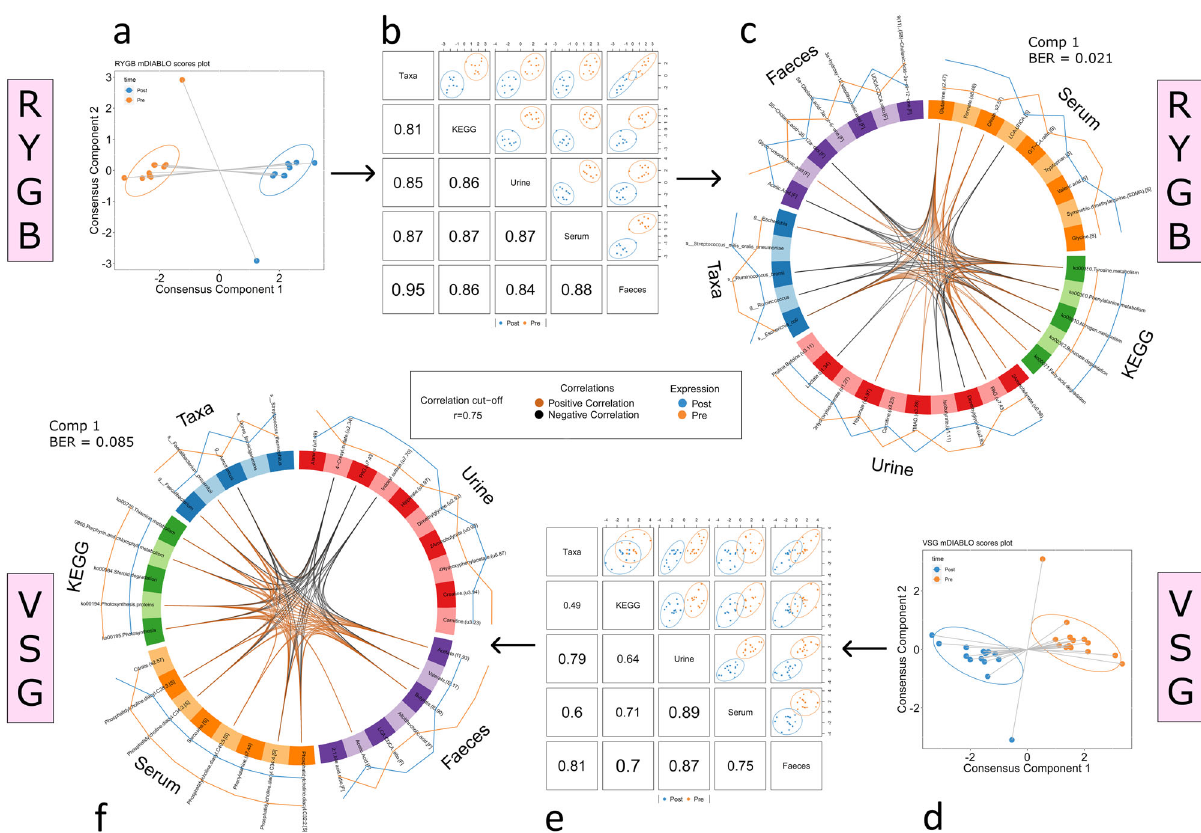
Fig. 6 Integration of metabolite and gut microbiota datasets. Multi-omic datasets pre and 3-months post Roux-en-Y Gastric Bypass (RYGB) ( a – c ) and Vertical Sleeve Gastrectomy (VSG) ( d – f ) procedures were integrated using multilevel Data Integration Analysis for Biomarker discovery using Latent cOmponents (mDIABLO). a , d Scores plots with samples projected in latent space for RYGB ( n = 10) and VSG ( n = 14) models respectively. Classes (pre-/ post-surgery) are discriminated along component 1. b , e Scores plots derived from component 1 of individual datasets, showing correlations between variables from each dataset. c , f Variables from component 1 (coloured by dataset) discriminating between pre/post timepoints are displayed. Differences in expression of variables pre-/post-surgery are shown by the colour-coded outer lines. Correlations ( r > 0.75) between variables are shown by the colour- coded inner lines. Cross-validated balanced error rates (BER) for each model are shown. Ellipses correspond to 95% con fi dence